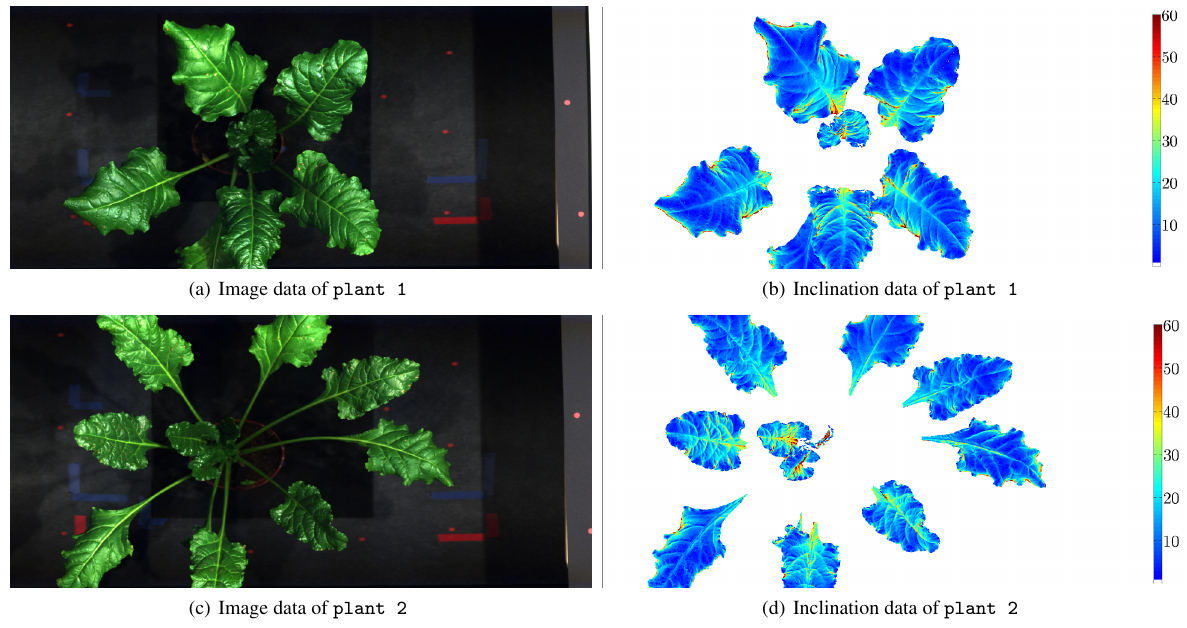
Figure 2: RGB image of both data sets plant 1 and plant 2 and their respective inclination information in degree. group orthogonal matching pursuit as an approximation to solve for the minimization in (1) using the approach presented in Szlam et al. (2012). The maximum number of dictionary elements is re- stricted to W .